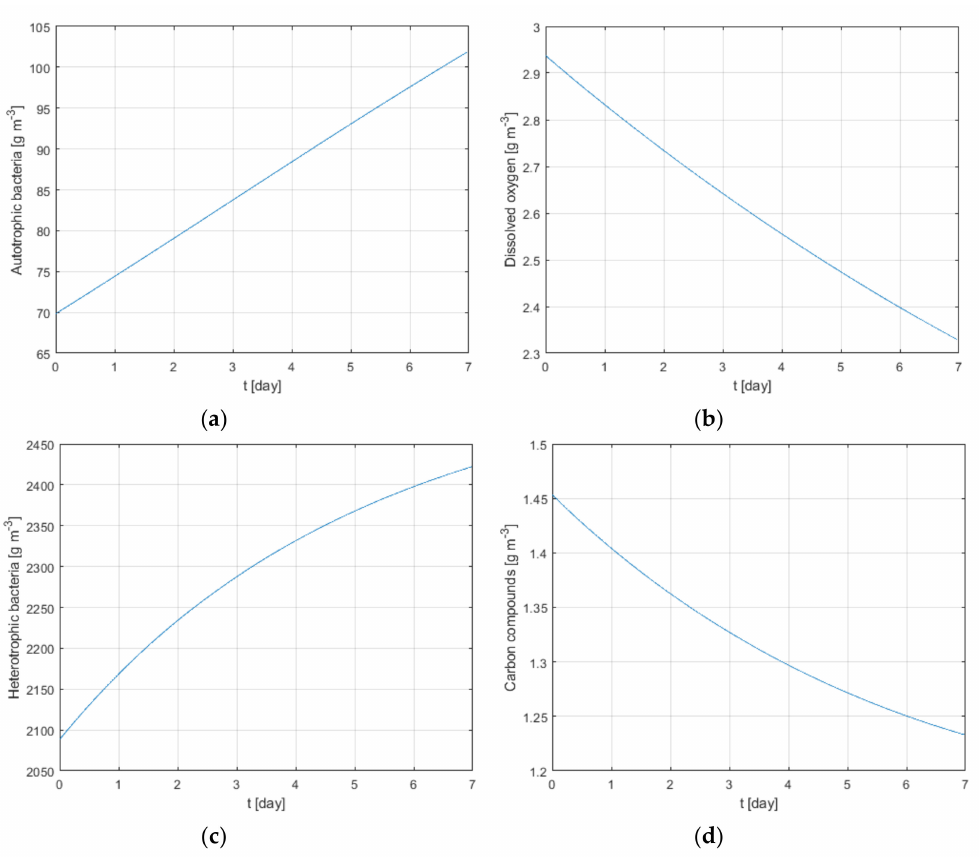
Figure 5. Dissolved oxygen ( a ), heterotrophic bacteria ( b ), autotrophic bacteria ( c ), and carbon substrate ( d ) in the first aeration tank.